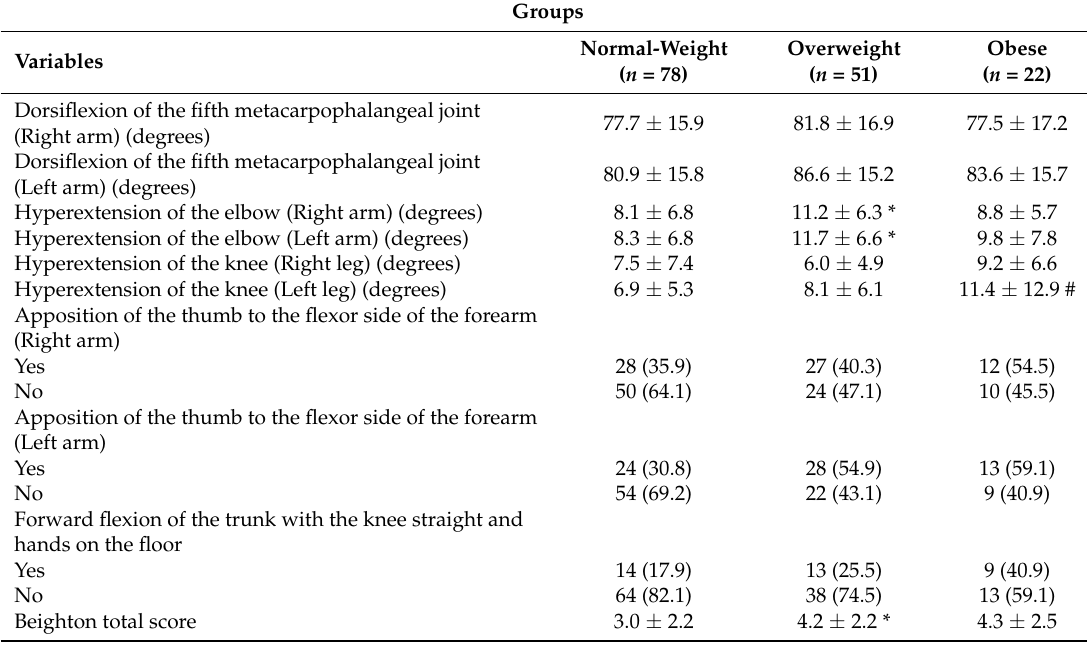
Table 3. Comparison of joint mobility among normal-weight, overweight and obese